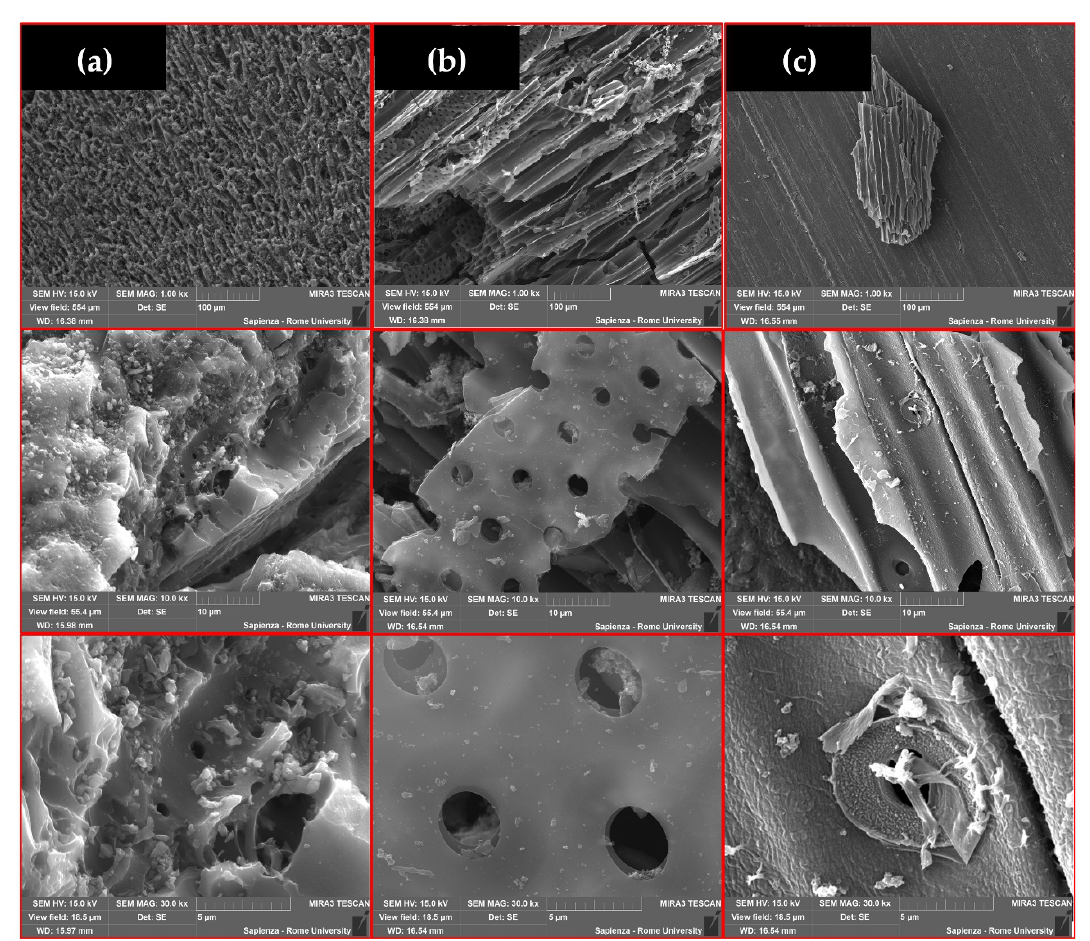
Figure 6. SEM images for CARBOSORB NC 1240 ® ( a ), AMBIOTON ® ( b ), and RE-CHAR ® ( c ). Com- parison with the three samples at the same magnifications (from the top: 1, 10, and 30 kX).